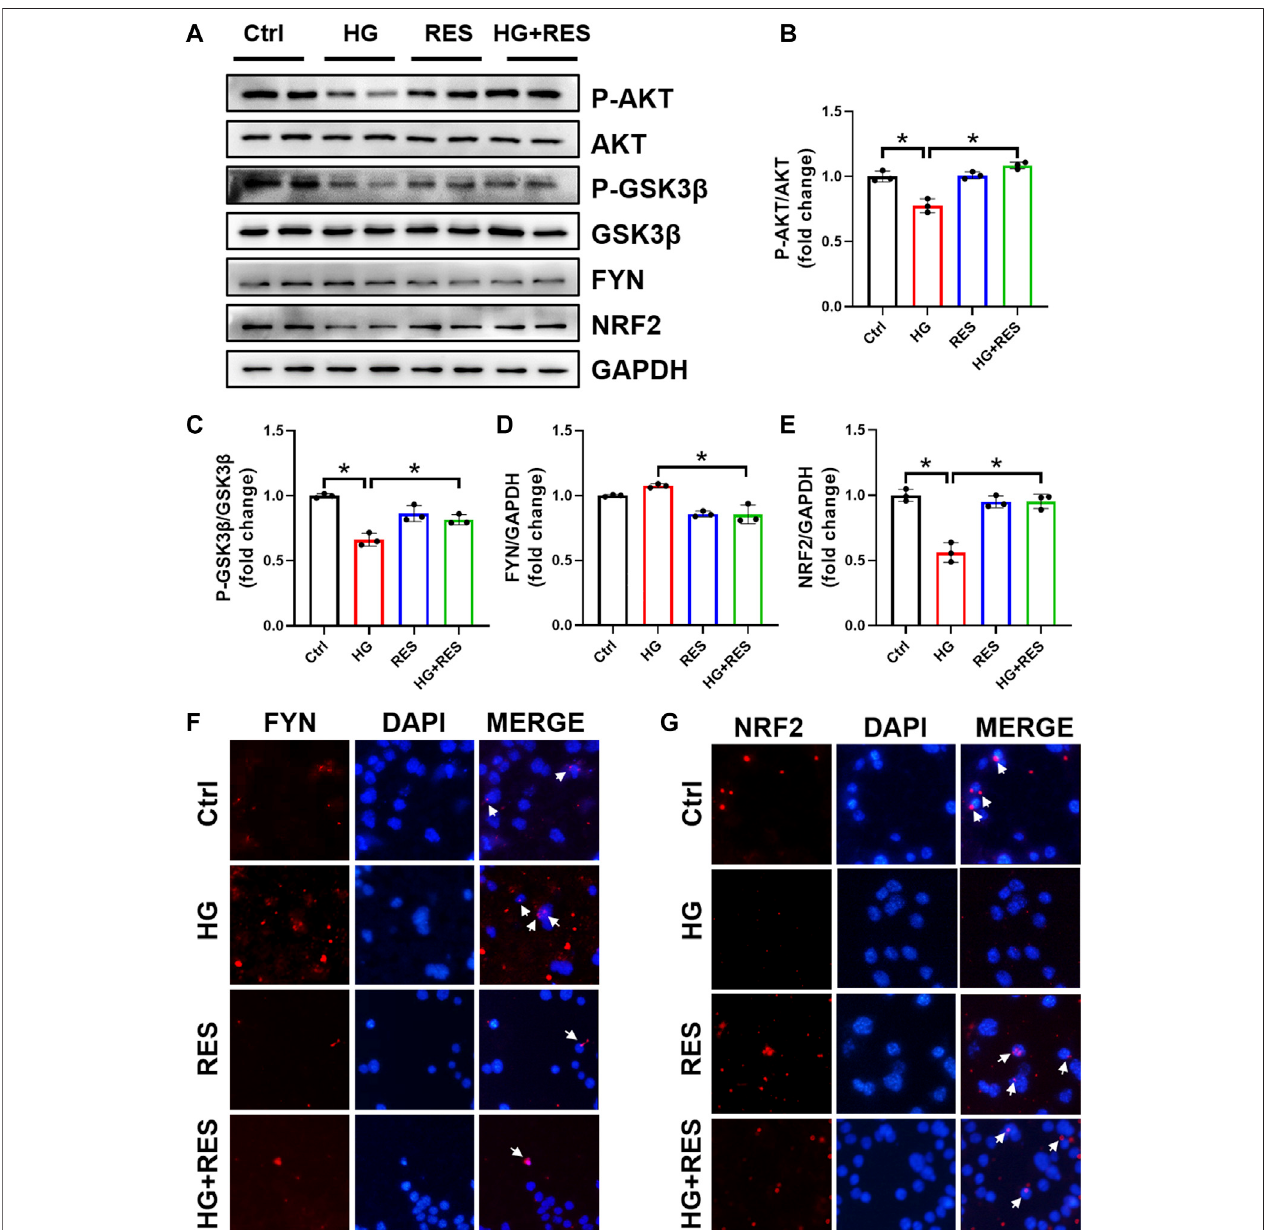
FIGURE 4 | Alternations of AKT, glycogen synthase kinase 3 β (GSK3 β ), FYN, and nuclear factor erythroid 2-related factor 2 (NRF2) protein expression under the HG condition with RES treatment in MC3T3-E1 cells. MC3T3-E1 cells were treated with vehicle, 30 mM HG alone, 5 μ M RES alone, or HG and RES for 24 h. (A – E) The protein expression of P-AKT, AKT, P-GSK3 β , GSK3 β , FYN, and NRF2 was detected by Western blot. GAPDH as an internal control. Three independent experiments were performed. (F,G) Representative images of immuno fl uorescent staining for (F) FYN and (G) NRF2 nuclear accumulation. Data are shown as mean ± SD. * p <